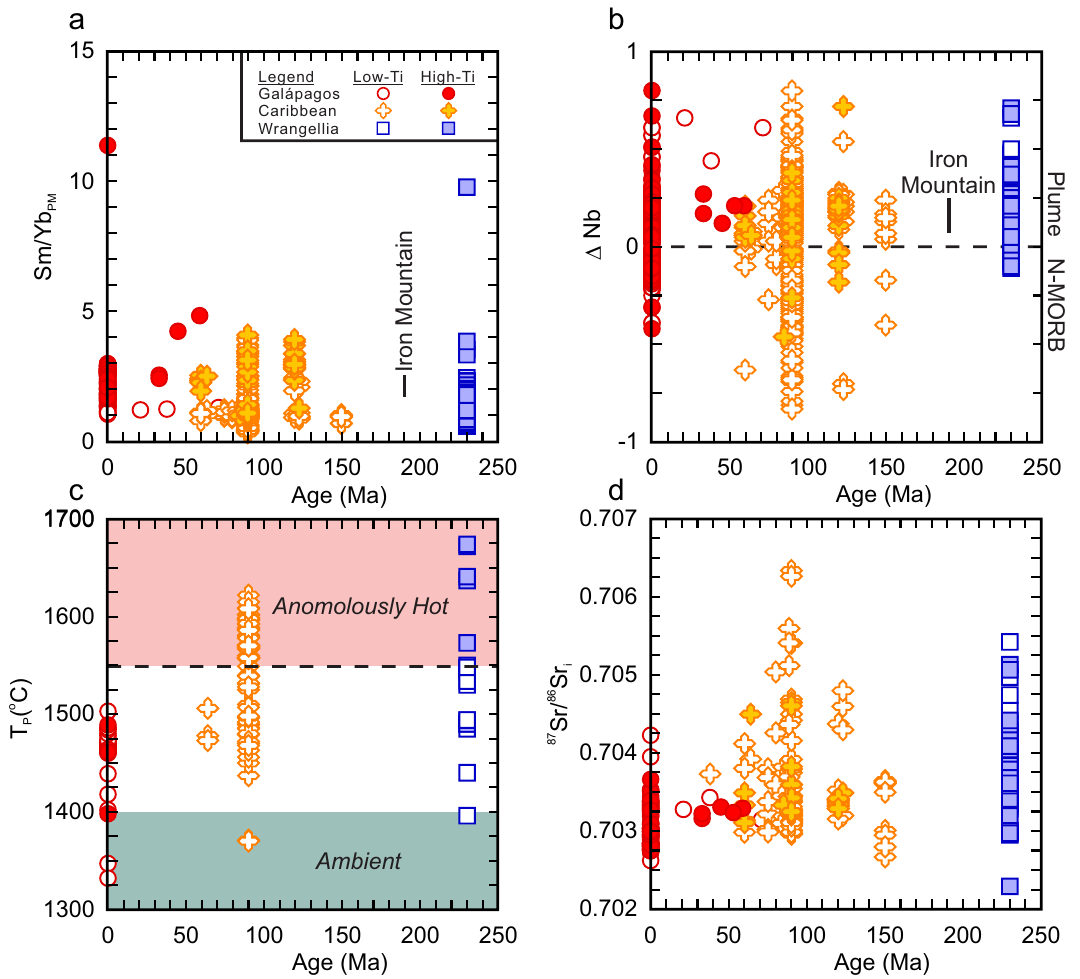
Figure 3. Secular geochemical comparison of the volcanic rocks of Wrangellia, Caribbean plateau, and Galápagos Islands using ( a ) Sm/Yb PM , ( b ) ΔNb, ( c ) calculated mantle potential temperature (T P °C), ( d ) initial 87 Sr/ 86 Sr ratio, ( e ), ε 206 Pb/ 204 Pb, ( g ) initial 207 Pb/ 204 Pb, and ( h ) initial 208 Pb/ 204 Pb. The range Nd ( t ), ( f ), initial of the Early Jurassic Iron Mountain within-plate rocks from the Ingalls ophiolite are shown in panels a and b 54 . PM = normalized to primitive mantle values 55 . ΔNb = 1.74 + log[Nb/Y] − 1.92log[Zr/Y]) 56 . If the age of the individual sample was not provided in the GEOROC database then it was assumed to be 230 Ma for the Wrangellia rocks, 90 Ma for the Caribbean rocks, and 0.01 Ma for the Galápagos